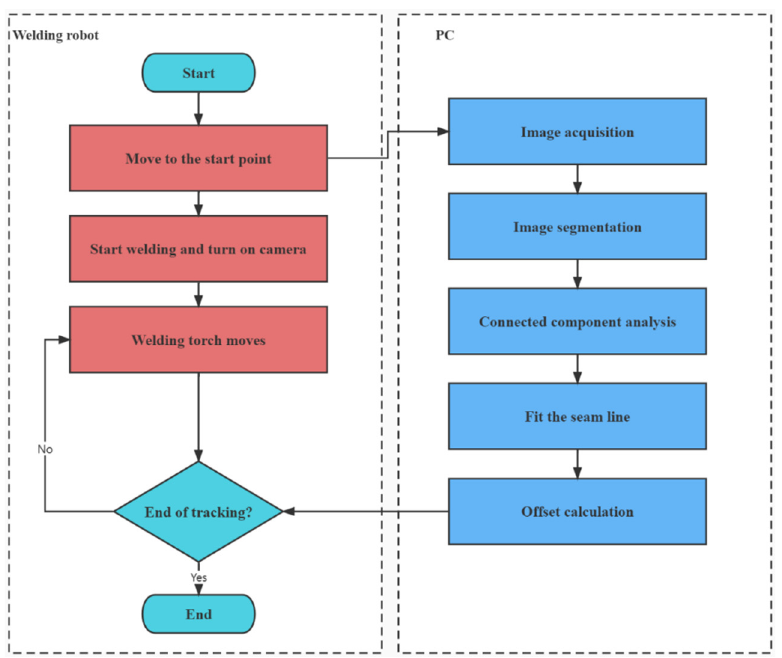
Figure 3. Flow chart of the welding seam tracking.